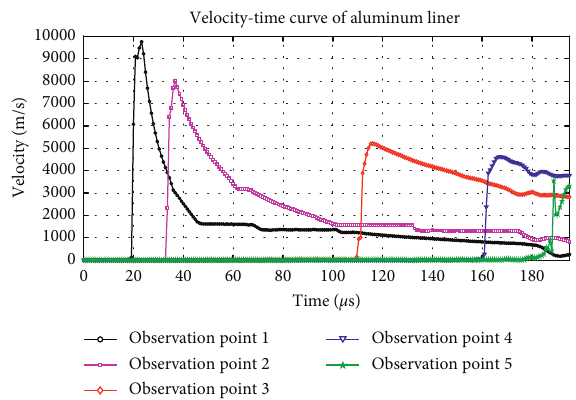
Figure 10: SCJ velocity curve of the aluminum